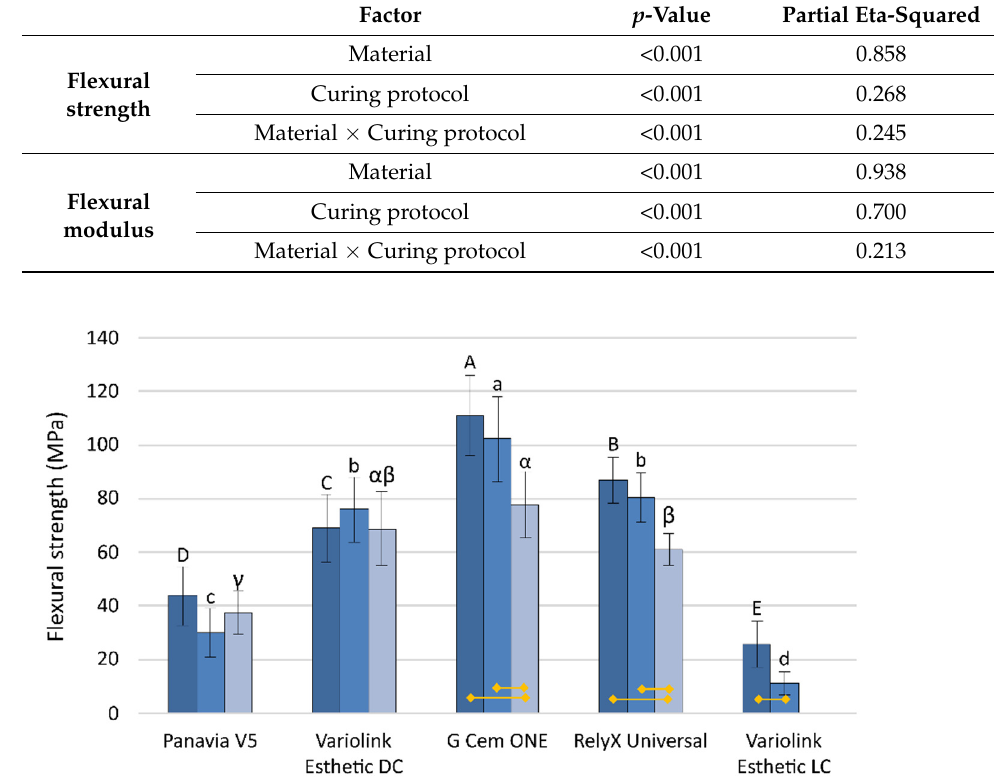
Table 3. Statistical significance ( p -values) and practical significance (partial eta-squared values) of the factors “material” and “curing protocol” for flexural strength and flexural modulus.